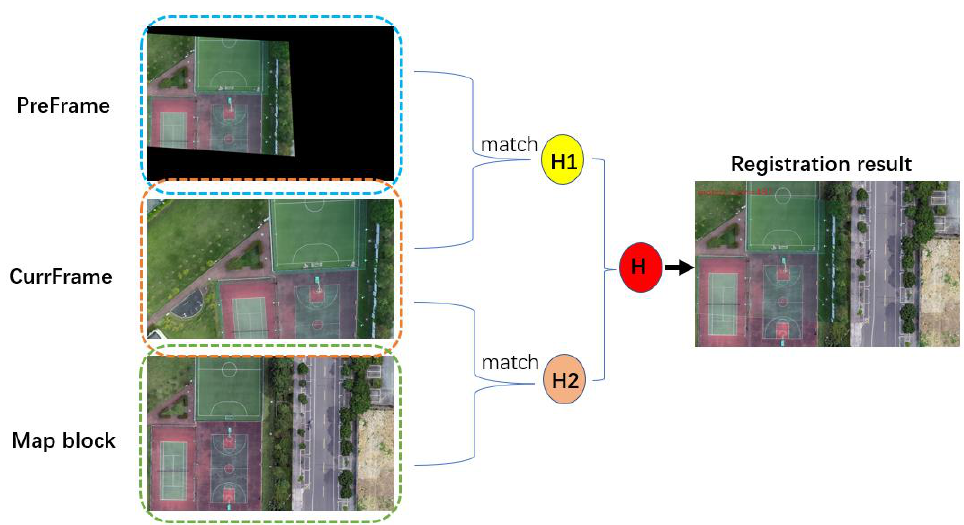
Figure 8. Weighted fusion of inter-frame and global matching in the figure, PreFrame represents the transformed previous frame and CurrFrame represents the current frame.